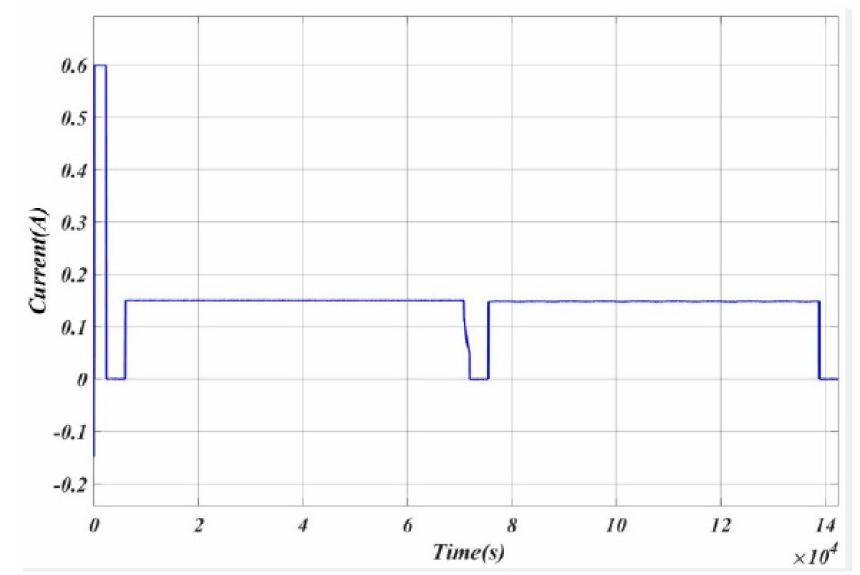
Figure 17. The pattern of the discharging current applied to both the